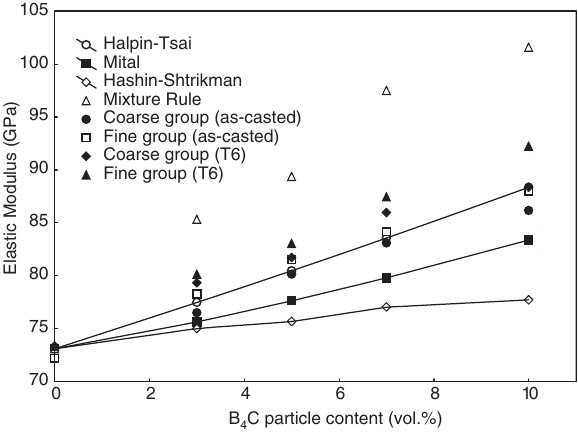
Figure 7 Comparison of measured elastic moduli with moduli predicted using upper and lower bound [57], Halpin-Tsai [58], and Mital [60] models.